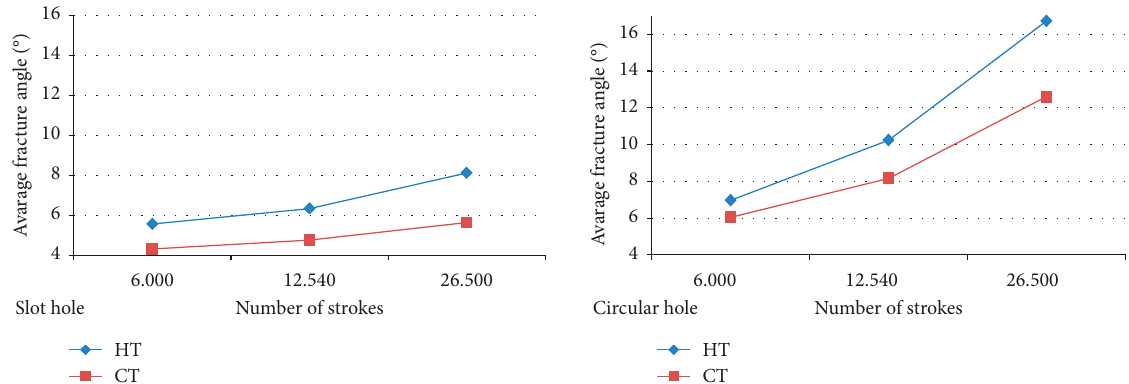
Figure 15: Average fracture angle of geometry of the cut surface of the holes of the control arm part (slot hole and circular